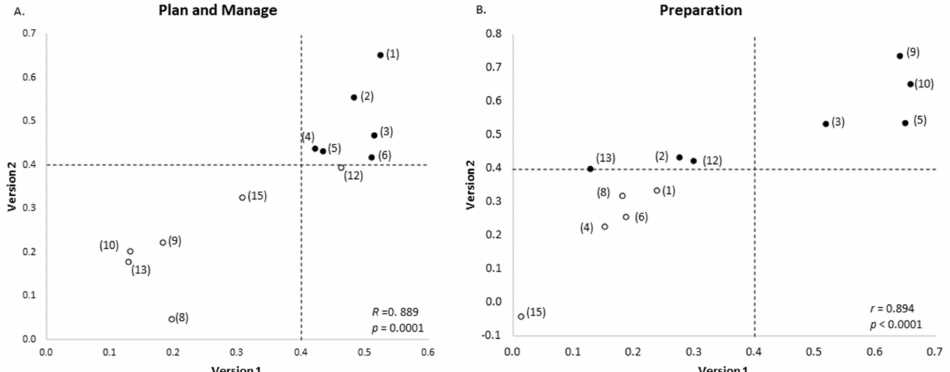
Figure 2. Comparison of factor loadings in food literacy behavior tools of those questions common to both questionnaires. ( A ) Plan and manage factor; ( B ) Preparation factor. x axis: original food literacy behavior tool based on Version 1 of the questionnaire. y axis: revised food literacy behavior tool from Version 2 of questionnaire. The dashed line indicates 0.4 cut-off used. Filled in points indicate factor loading ≥ 0.4 in analysis of questionnaire Version